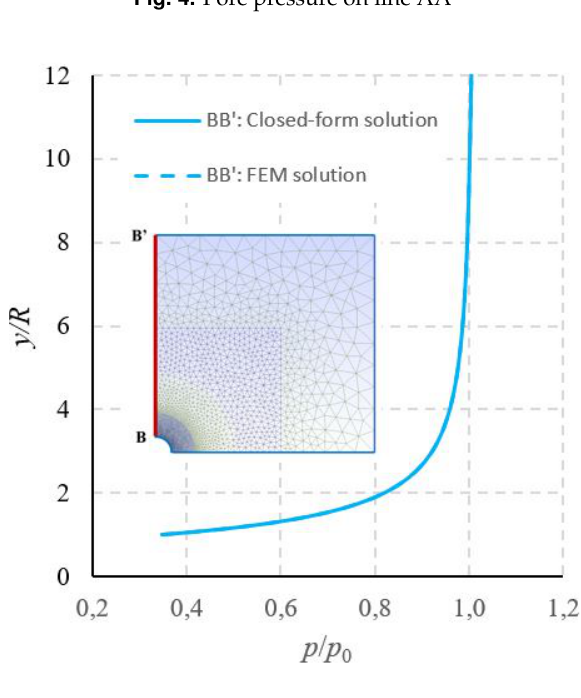
Fig. 5. Pore pressure on line BB ′